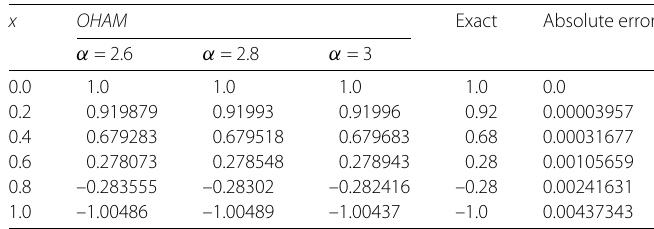
Table 2 Exact and approximate result of Test example 4.2 with various values of α x OHAM Exact Absolute